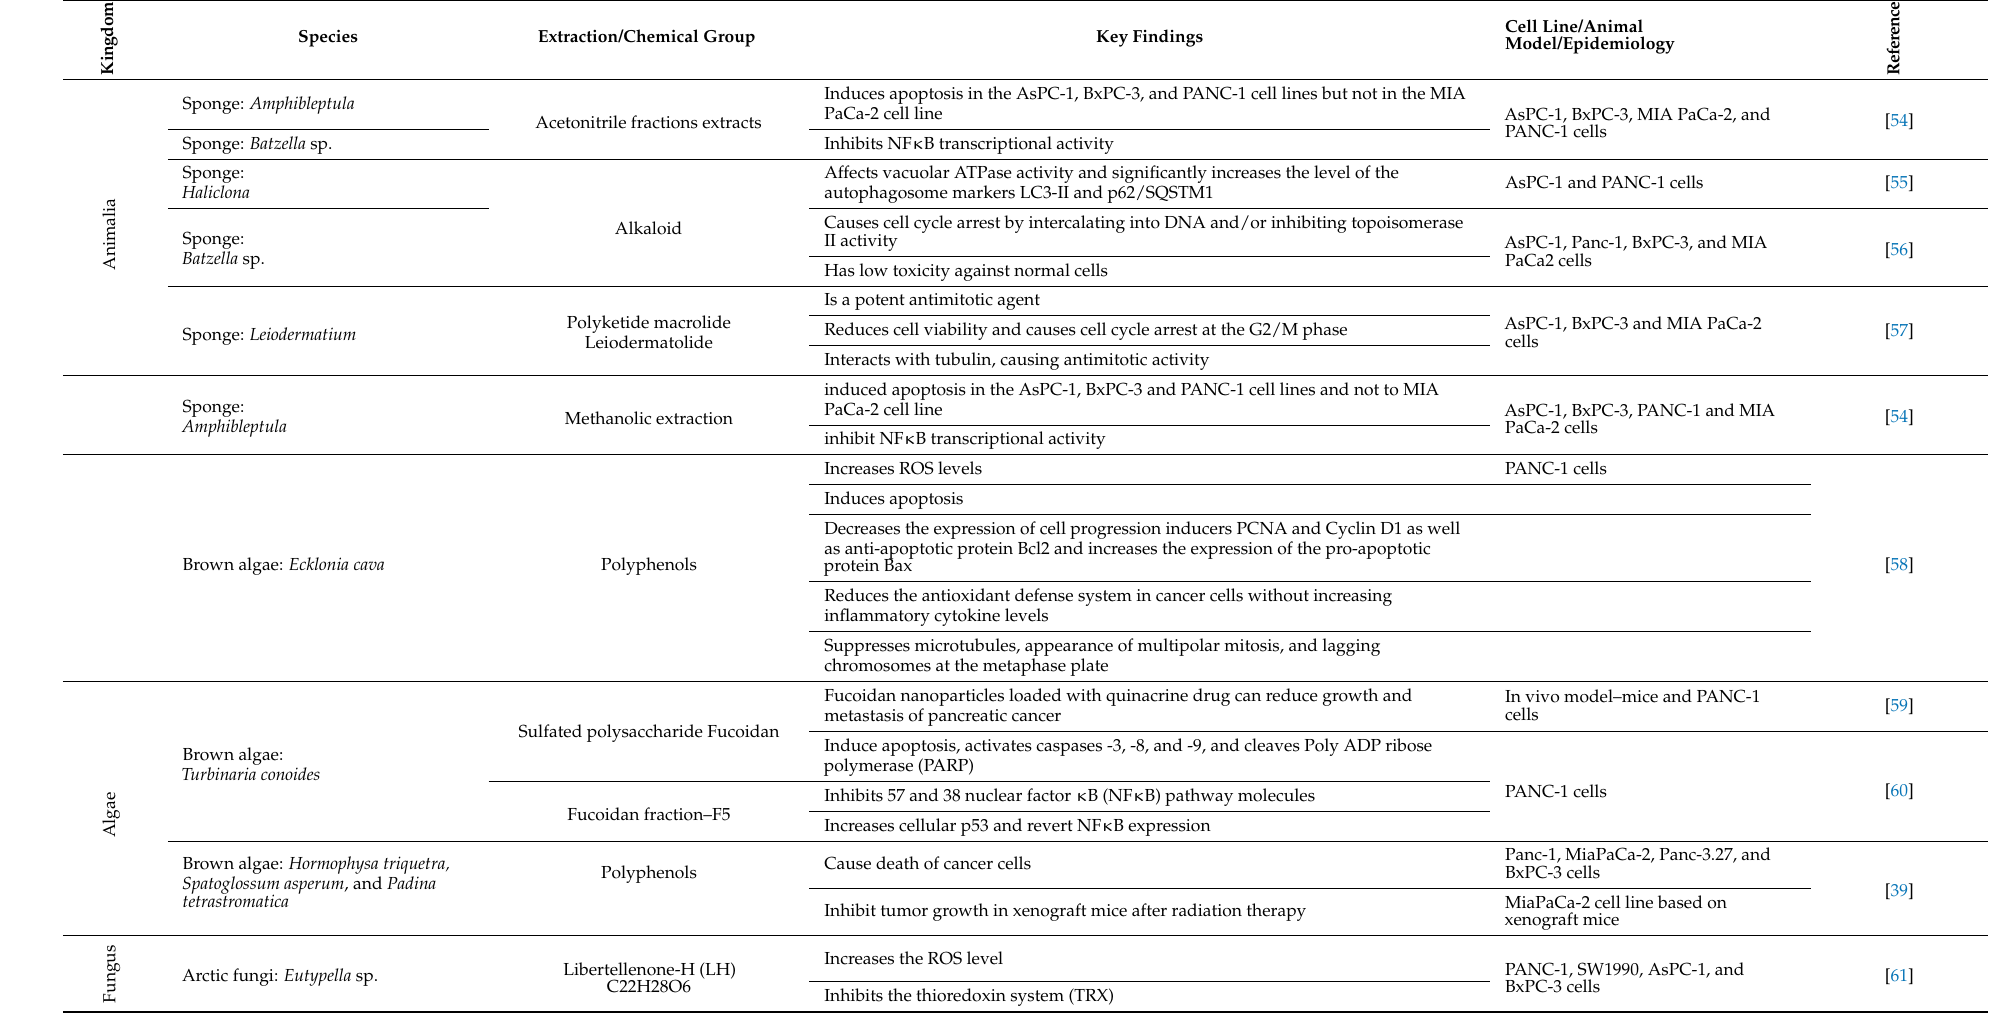
Table 2. Marine origin with anti-pancreatic cancer